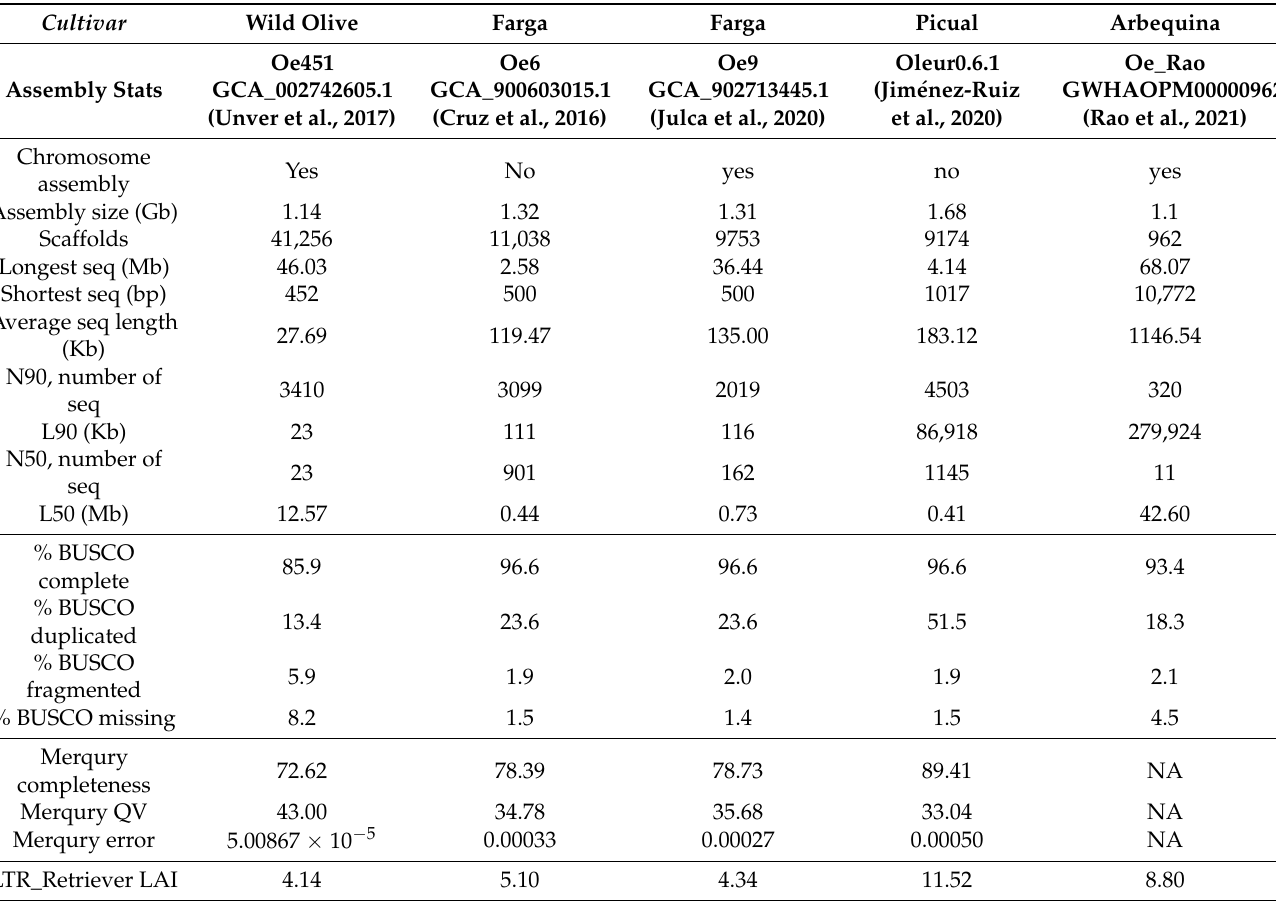
Table 2. Genome assembly and contiguity